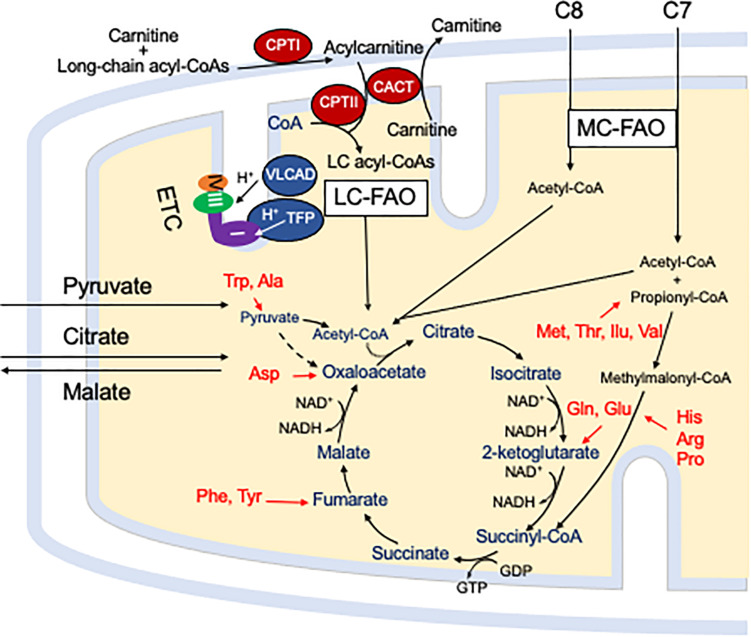
The carnitine cycle involves generation of a long chain acylcarnitine from activated fatty acids by CPT I, transport across the mitochondrial membranes by CACT, and release of the activated acyl-CoA substrate for FAO into the mitochondrial matrix by CPT II. Carnitine itself is transported into cells by a high affinity transporter (OCTN2). All abbreviations are as defined in the text. Interactions of mitochondrial energy metabolism pathways. The carnitine cycle transport long-chain CoAs into the mitochondrial matrix with carnitine ultimately being restored to the cytoplasm in exchange for release of an acyl-CoA in the mitochondrial matrix. Medium chain fats directly diffuse into mitochondria. ETC and the enzymes of LC-FAO functionally and physically interact. Mitochondrial TFP interacts with and passes its reducing equivalents to the matrix arm of ETC complex I. VLCAD interacts with TFP, but its reducing equivalents are transferred to ETC complex III via electron transfer flavoprotein (ETF, not shown) and ETF dehydrogenase (not shown). The acetyl-CoA product of one cycle of FAO enters the TCA cycle to produce citrate. While standard medium chain trioctanoylglycerol (C8) provides double the amount of acetyl-CoA compared to triheptanoin (C7), the latter provides a propionyl-CoA that enters the TCA cycle through succinyl-CoA. Anaplerotic amino acids are listed in red. Pyruvate and citrate enter the mitochondria through specific carriers (the latter with counter transport of malate to the cytoplasm). All abbreviations are as defined in the text.